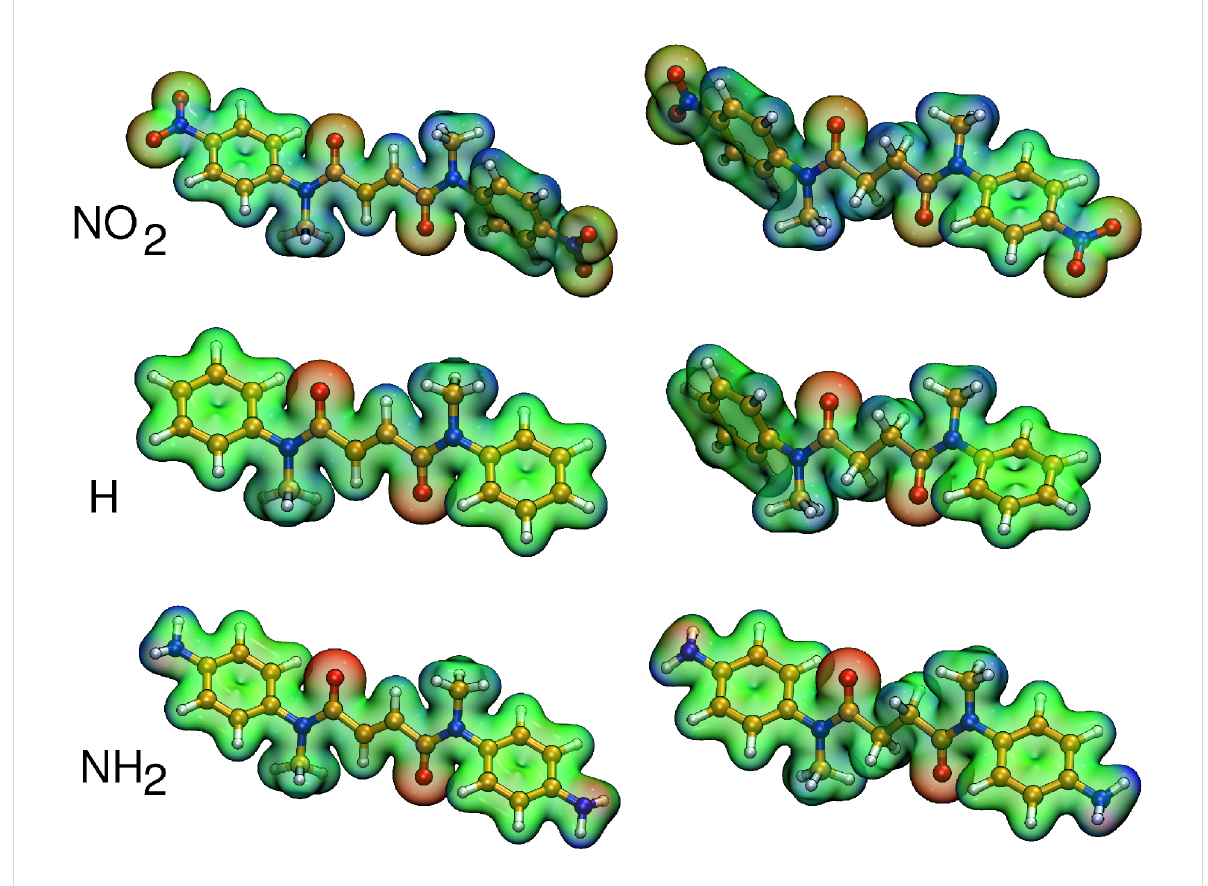
Figure 3: Electrostatic potential for the complexes 2a@1 (top left), 2e@1 (middle left), 2h@1 (lower left) and 3a@1 (top right), 3e@1 (middle right), 3h@1 (lower right).